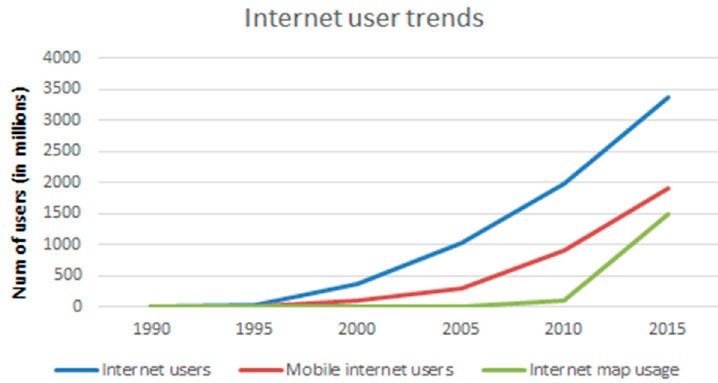
Figure 7. Growth in number of users on the Internet.